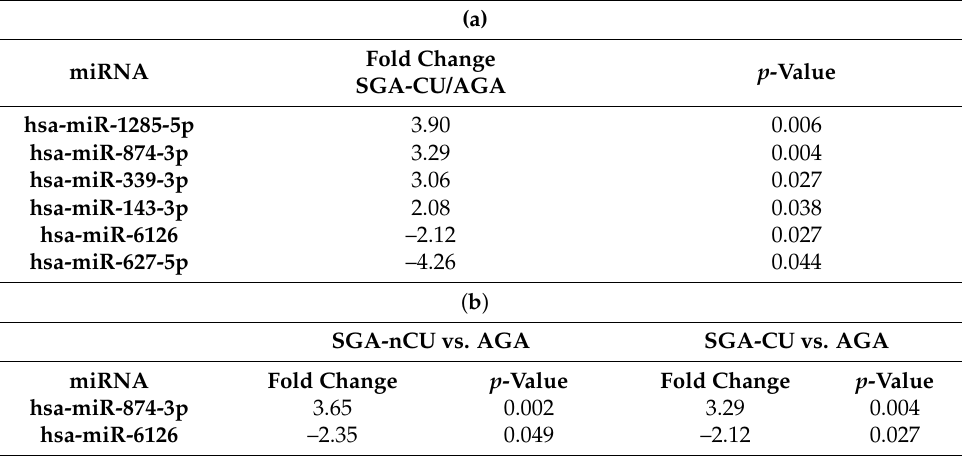
Figure 3. Heat map of the Z-scores of exosomal miRNAs for the SGA-CU (n = 5) and AGA (n = 5) groups. Table 5. Exosomal miRNA profile of the SGA-CU and AGA groups. ( a ) Fold change in exosomal miRNA expression of the SGA-CU group compared with the AGA group. ( b ) miRNAs with similar expression trends between SGA-nCU and AGA, and between SGA-CU and AGA.